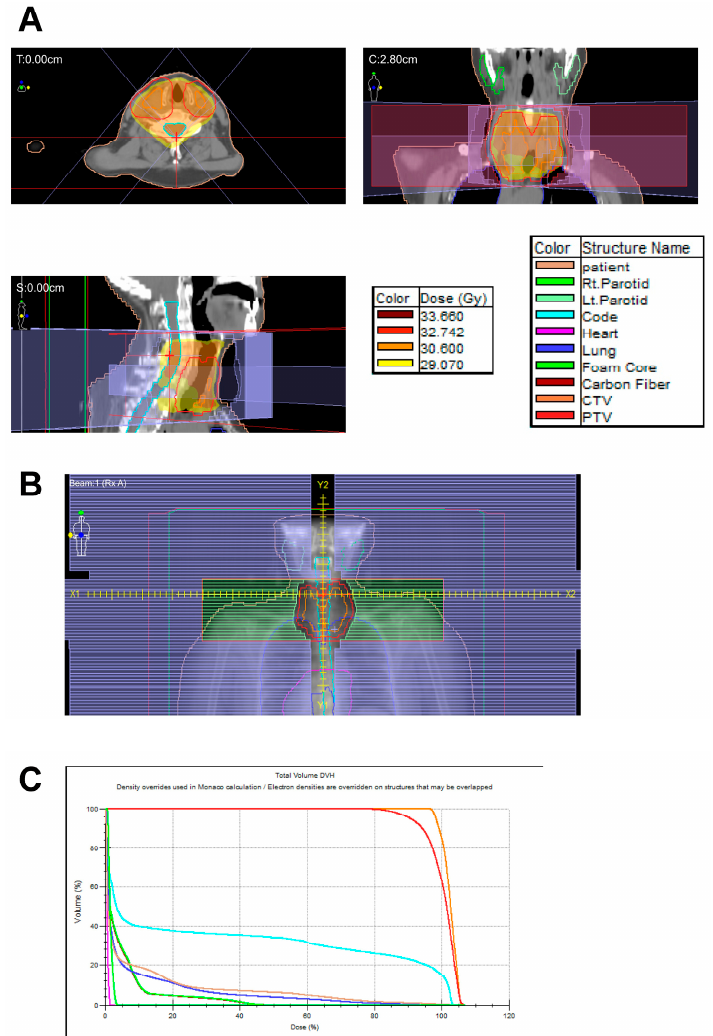
Figure 1. Typical radiation treatment planning for stage IE primary thyroid mucosa-associated lymphoid tissue (MALT) lymphoma at Ito Hospital. Tables of color correspondence ( A ) Radiation dose distribution on the treatment planning CT image. The lower right is the corresponding table between color lines in ( A – C ) and structure names. Orange line: the clinical target volume (CTV). Red line: the planning target volume (PTV). ( B ) Beam’s eye view demonstrates that the radiation protocol for stage IE minimizes salivary gland irradiation outside of the PTV. ( C ) The cumulative dose-volume histogram (DHV) also shows that the radiation doses toward the right and left parotids (yellowish-green curves) are